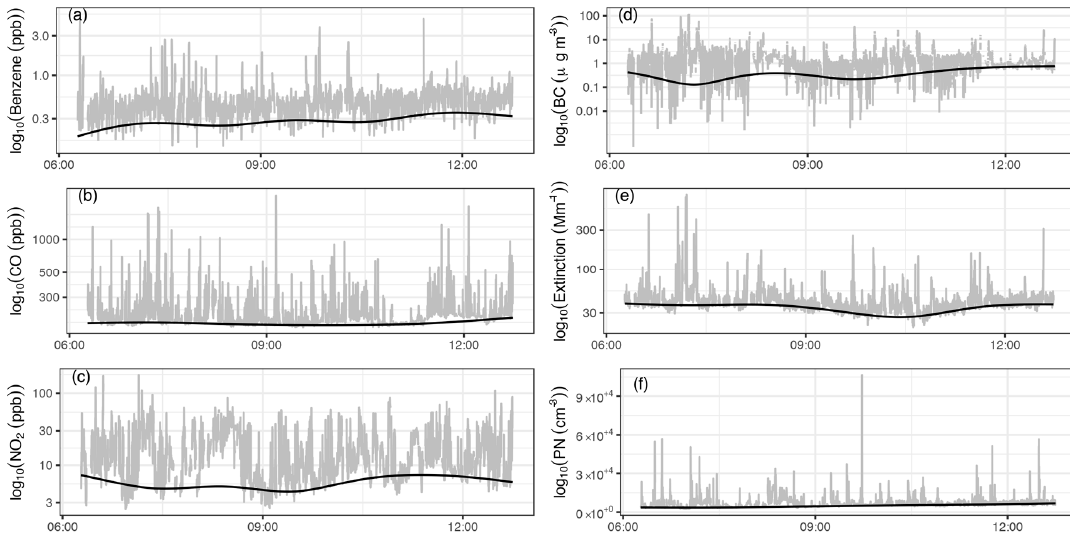
Figure 3. Example sampling session (concentration values in black) and estimated background concentrations (shown in black).